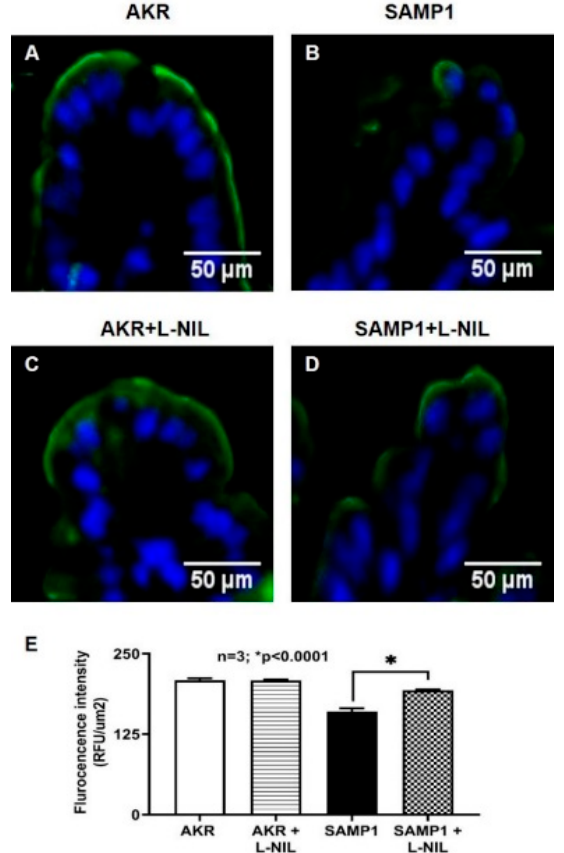
Figure 10. Immunofluorescence of SGLT1 in SAMP1 mice intestine. Images captured at 10X magnification. ( A ) SGLT1 in AKR mouse intestine, demonstrating its abundance in the BBM of villus cells lining the villus. ( B ) SAMP1 mouse intestine demonstrating the diminished SGLT1 in the BBM of villus cells lining the villus. ( C ) SGLT1 in L-NIL treated AKR mouse intestine, demonstrating that SGLT1 expression is unchanged in the BBM of villus cells. ( D ) L-NIL treated SAMP1 mouse intestine demonstrating the restoration of diminished SGLT1 in the BBM of villus cells. ( E ) Quantitation of SGLT1 in AKR and SAMP1 mice intestine, demonstrating that L-NIL treatment reverses the inhibition of SGLT1 in SAMP1 mice.